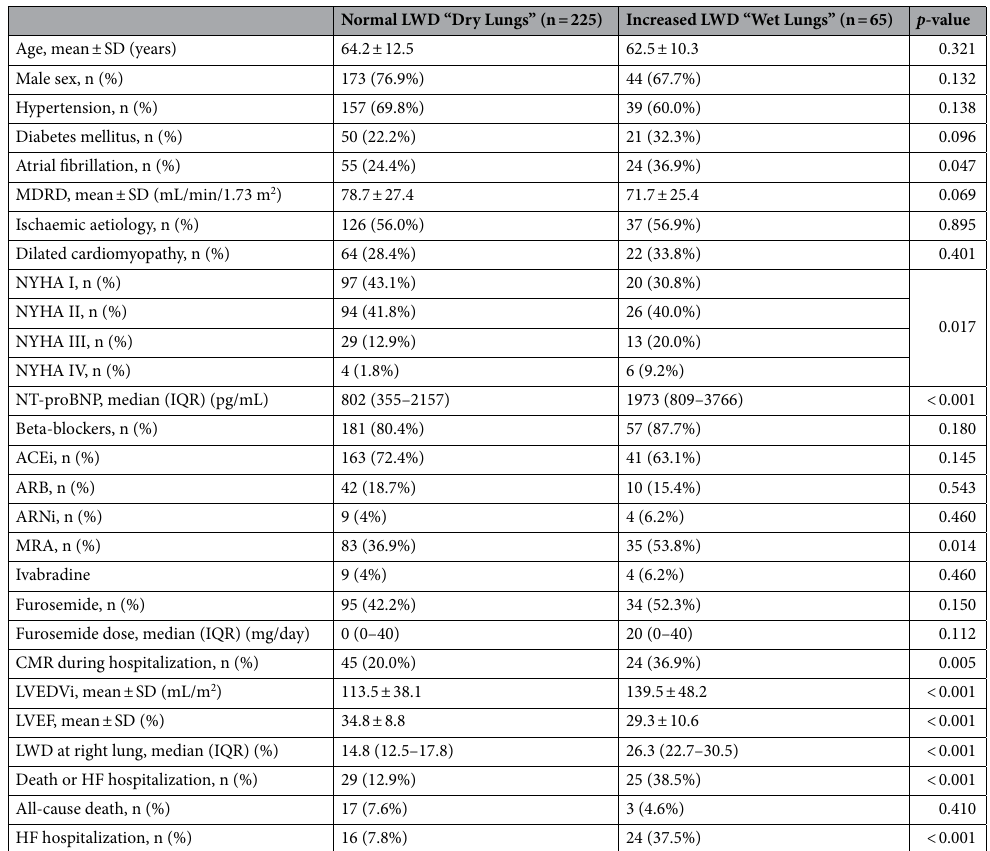
angiotensin II receptor blocker, ARNi angiotensin receptor-neprilysin inhibitor, CMR cardiac magnetic resonance, HF heart failure, IQR interquartile range, LV left ventricle, LVEDVi left ventricle